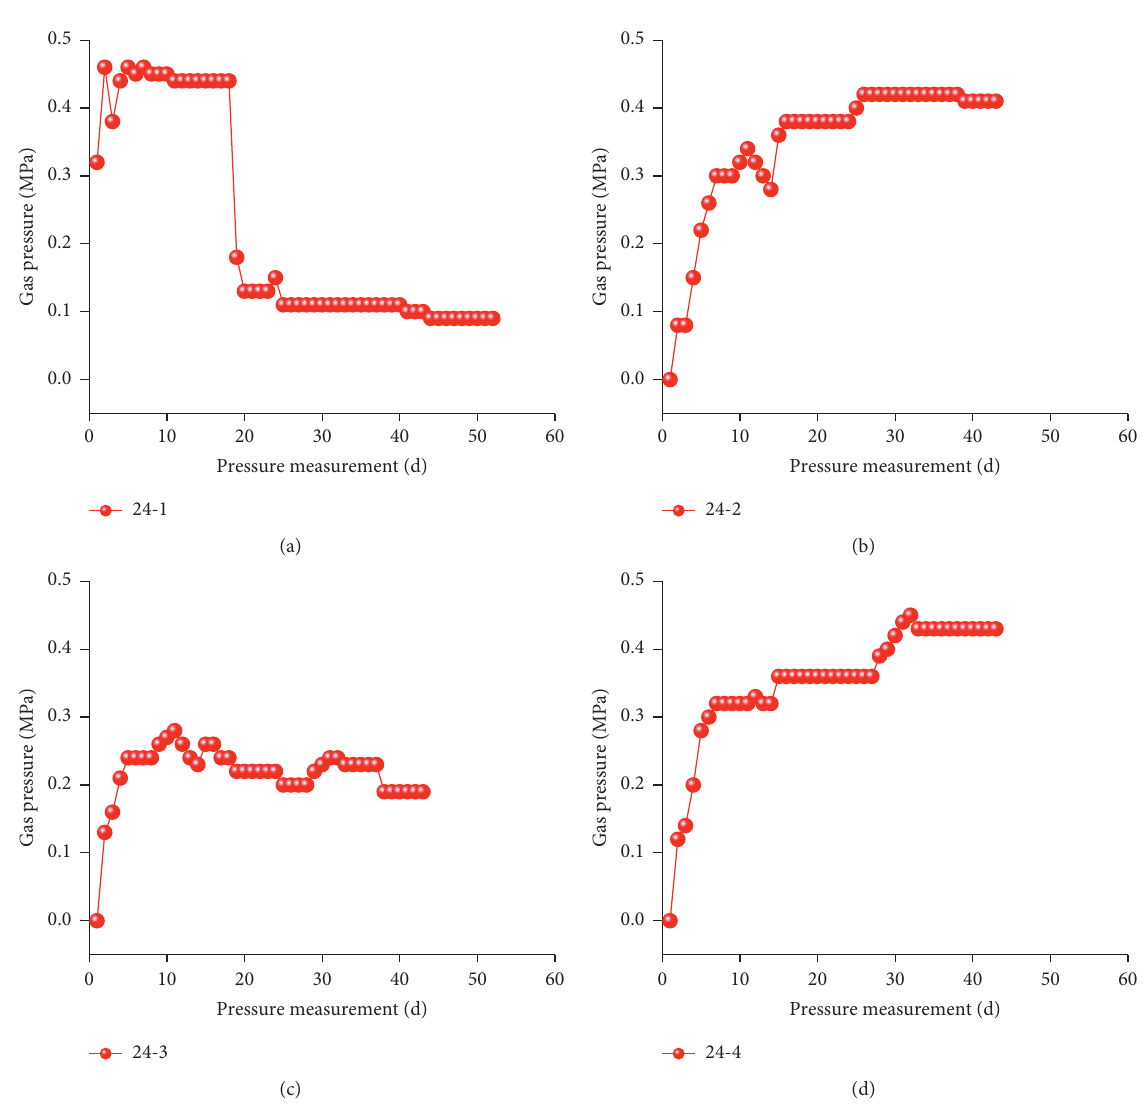
Figure 7: Gauge pressure and time curve of the No. 24 drilling